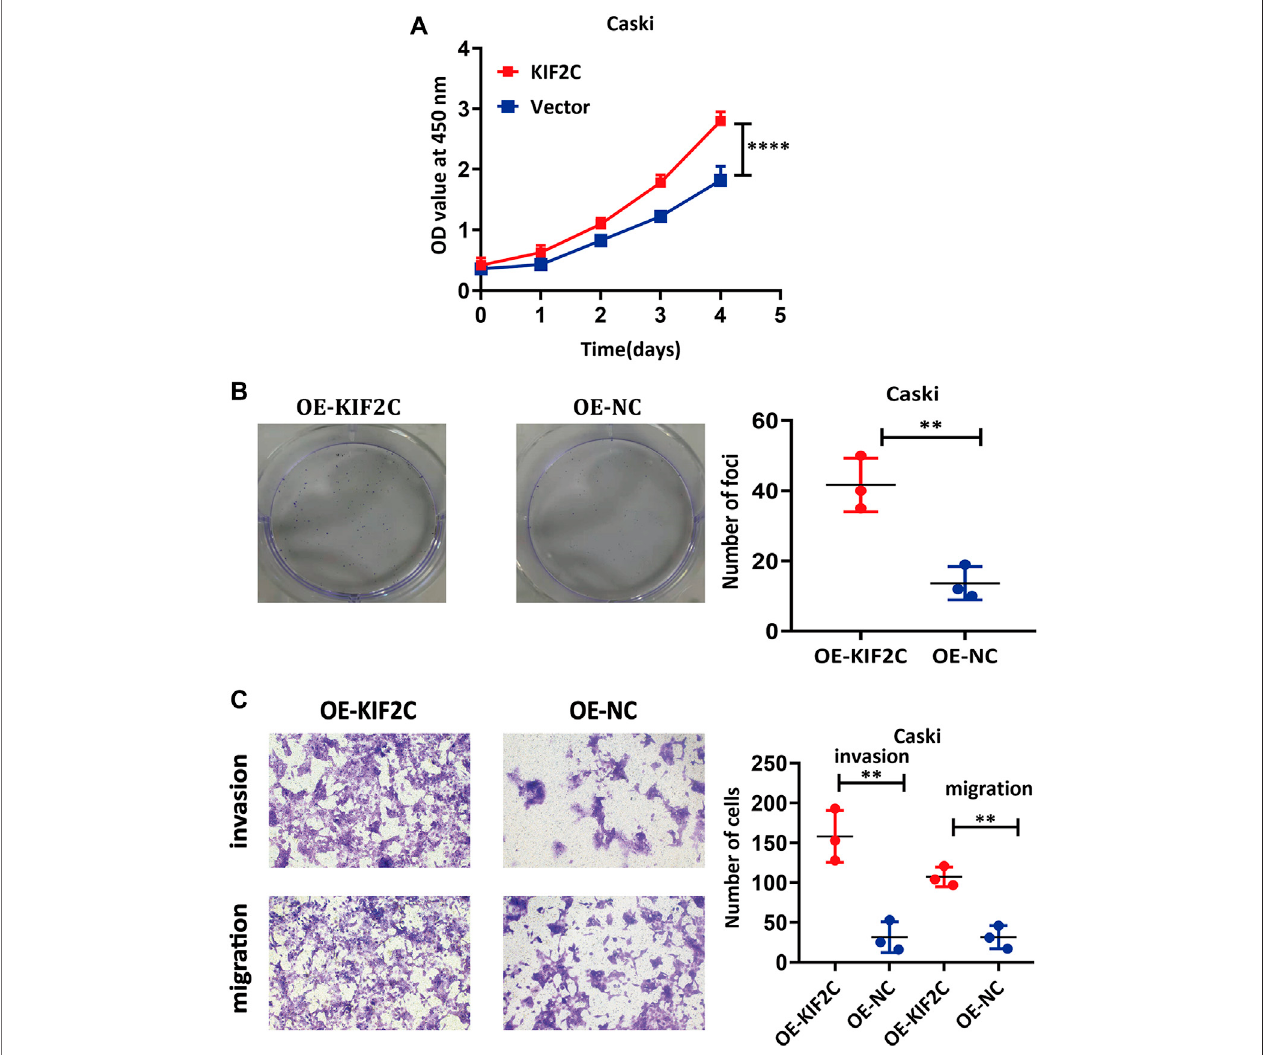
FIGURE 8 | KIF2C overexpression promoted tumorigenicity of cervical cancer cells. CCK-8 assay (A) and colony formation assay (B) were used to evaluate ability of cell proliferation in cervical cancer cells with KIF2C overexpression; dot plots in right showed results of quantitative analyses. (C) Migration and invasion of cervical cancer cells were determined after KIF2C overexpression and quanti fi cation of number of cells in migration and invasion. **p < 0.01; ***p < 0.001.